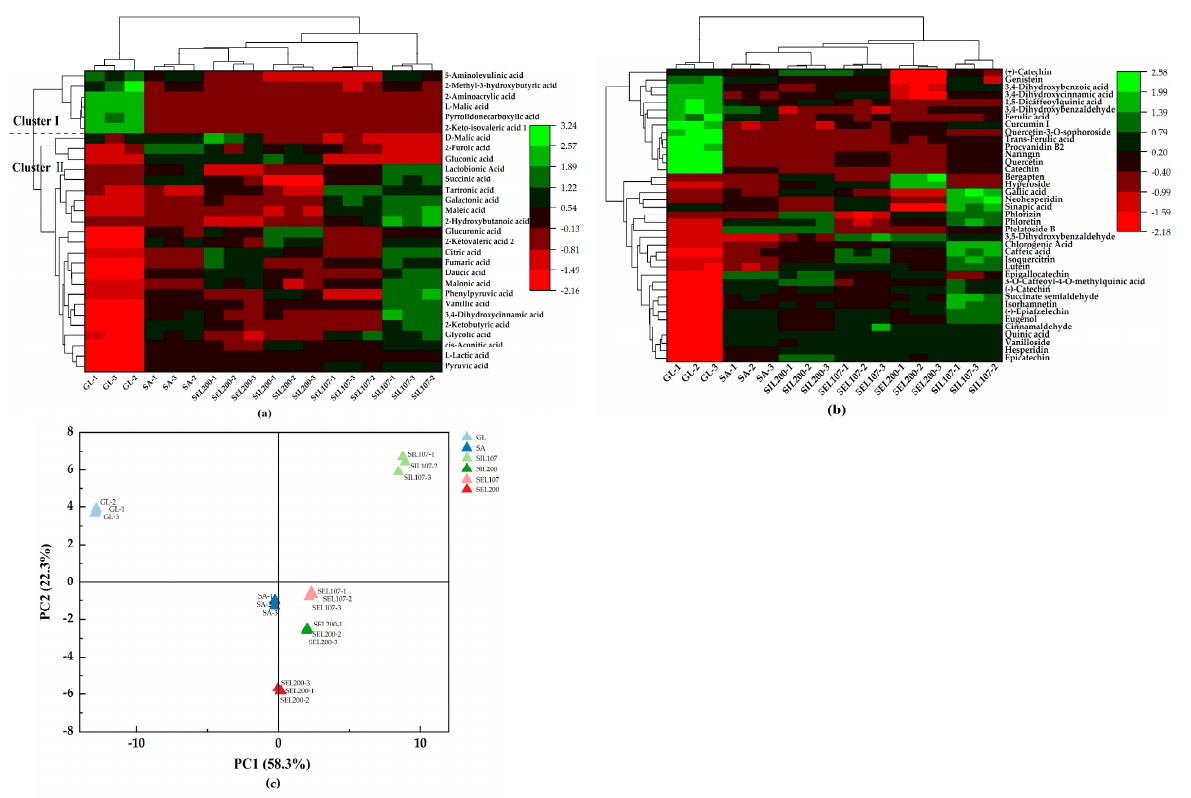
Figure 5. Non-volatile compounds of apple juice and ciders fermented by pure and mixed cul- tures. Cluster heatmap of organic acids ( a ) and polyphenols ( b ) in apple juice and ciders. ( c ) Prin- cipal component analysis (PCA) based on the non-volatile compounds of apple juice and ciders.